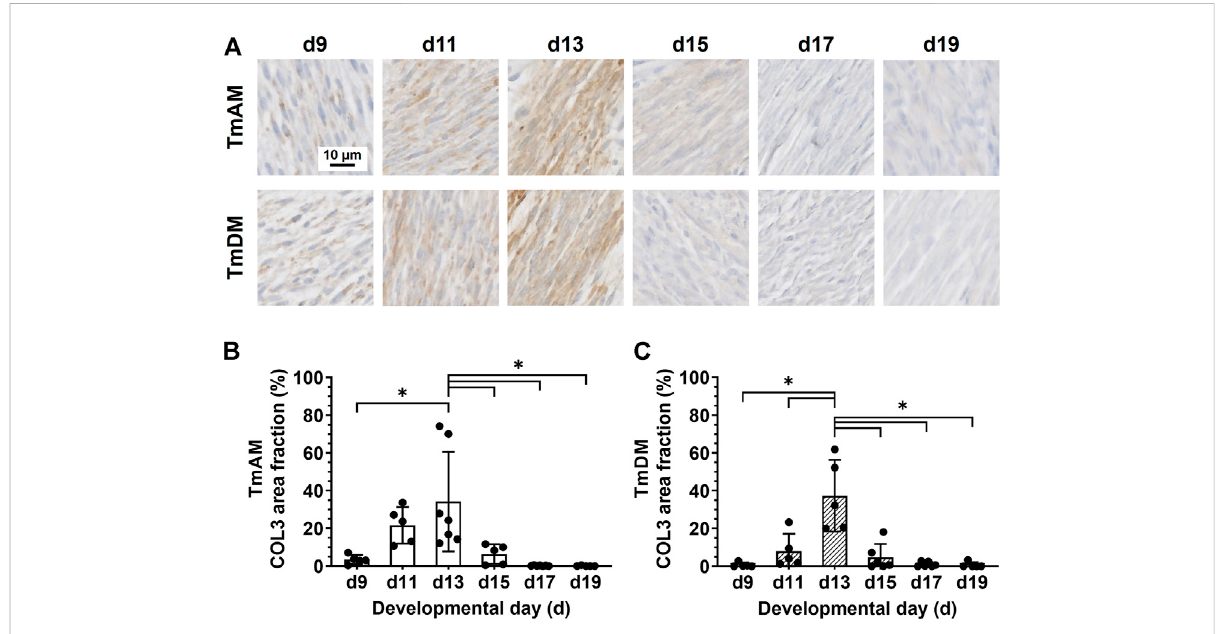
FIGURE 6 COL3decreasedafterd13inbothjaw-closingTmAMandjaw-openingTmDM. (A) Representativebright fi